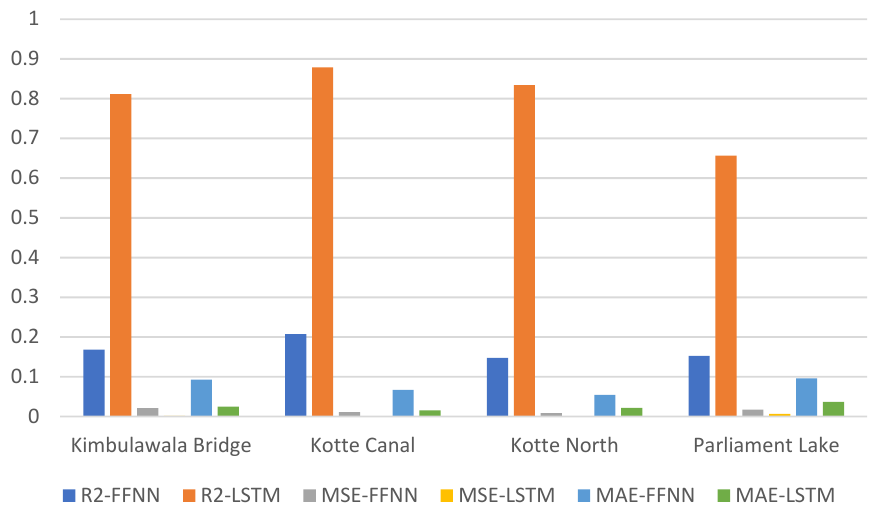
Figure 5. Representation of water level prediction performances.